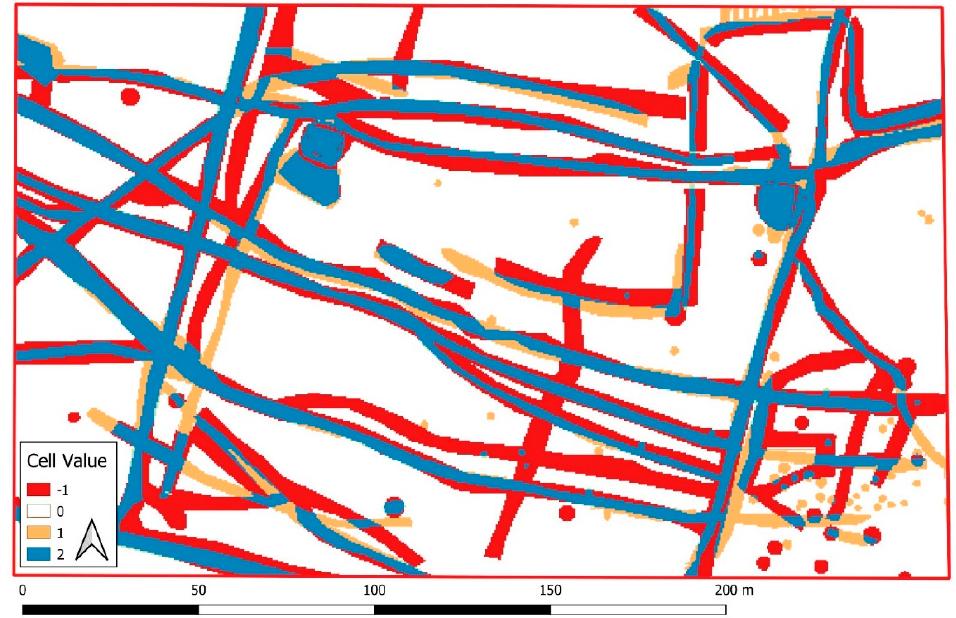
Figure 8. Comparison of Spring 2007 and 18 June 2012 datasets. Light orange features were detected solely in the older data, red exclusively in the later, and blue in both.